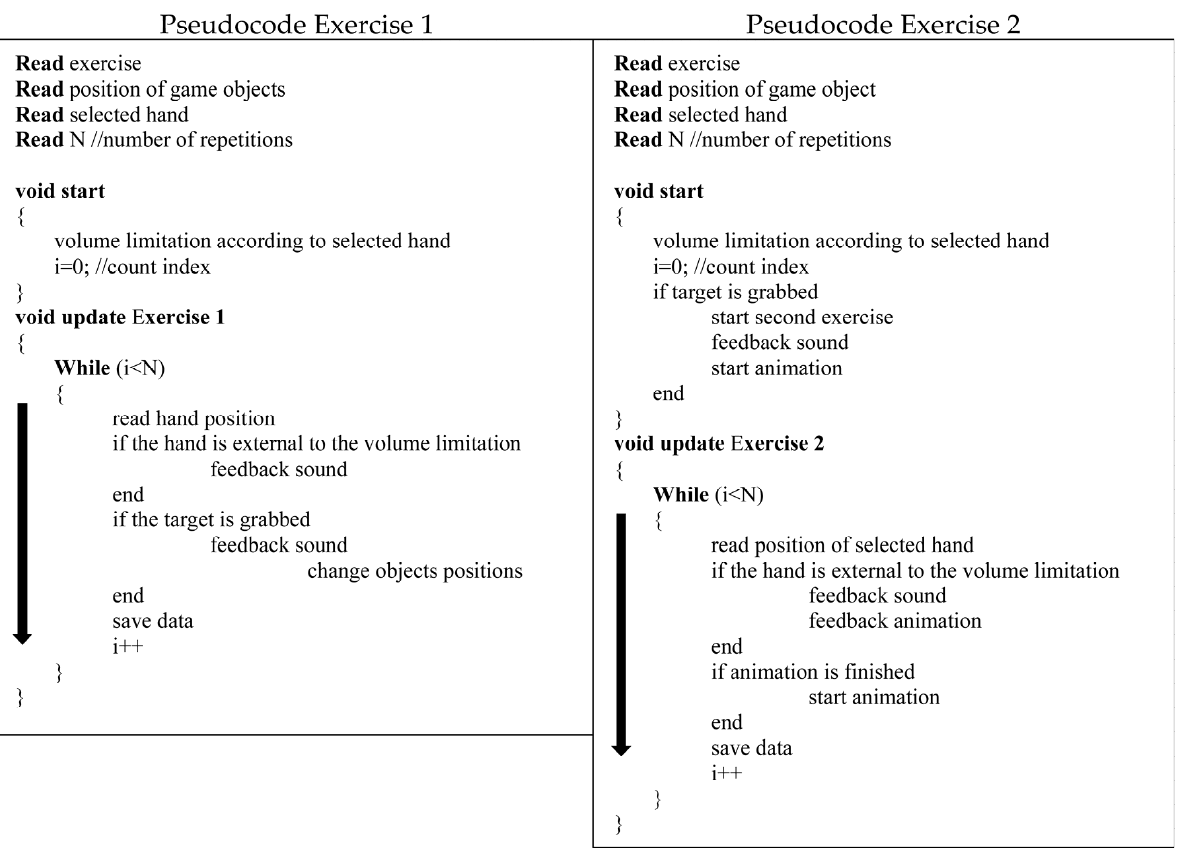
Figure 3. Pseudocodes of the exergaming implemented in C# style and reporting the conditions and feedbacks generated. feedbacks